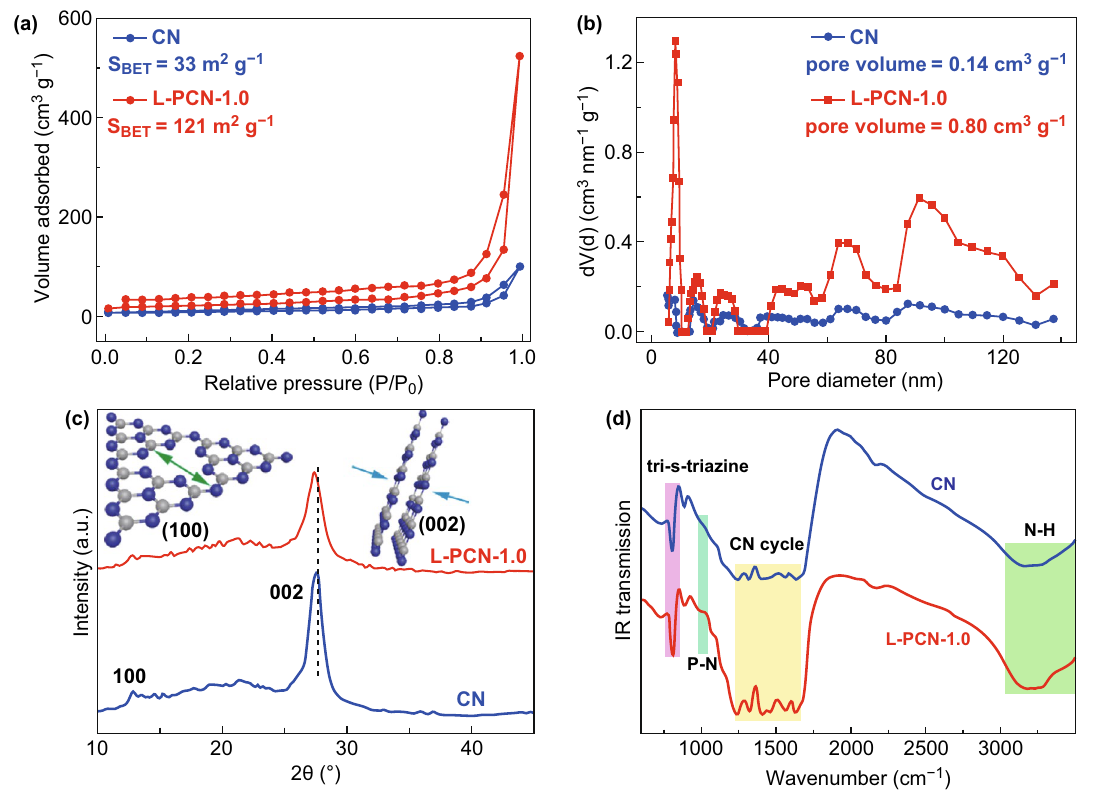
Fig. 3 Texture properties and chemical structures of CN and L‑PCN. a Nitrogen adsorption–desorption isotherms and b corresponding pore size distribution curves of CN and L‑PCN‑1.0. c , d XRD patterns and FTIR spectra of CN and